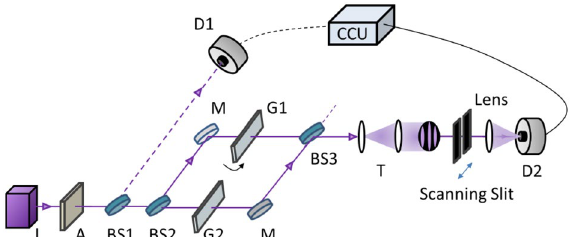
Figure 1. Schematic of quantum superposition for self-interference in an MZI. A—attenuator, BS—beam splitter, CCU—coincidence counting unit, D1/D2—single photon detector, G1/G2—1-mm thick glass plate, L—405 nm laser, M—mirror,